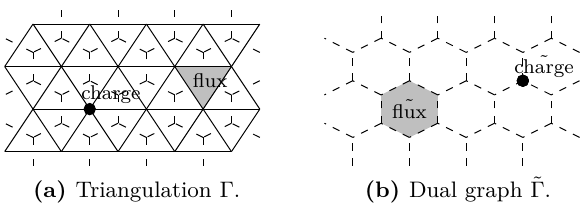
Figure 1 . EM duality between an Abelian gauge theory defined on the triangulation lattice Γ and its dual model on the dual graph ˜Γ . Gauge charges on vertices and gauge fluxes on plaquettes for gauge group G are mapped to dual fluxes and dual charges for the dual gauge group ˆ G on the dual